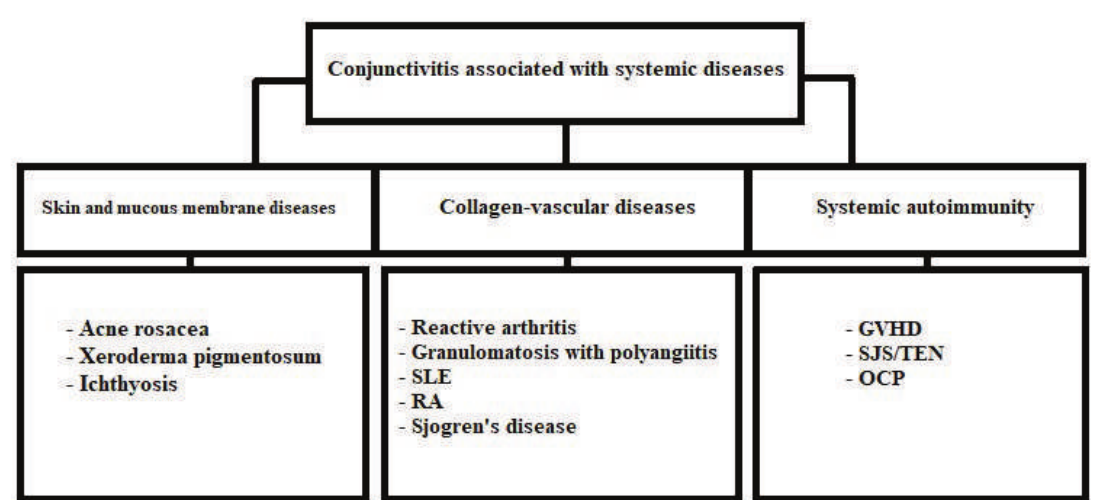
Figure 7. Some systemic and dermatological conditions associated with conjunctivitis.